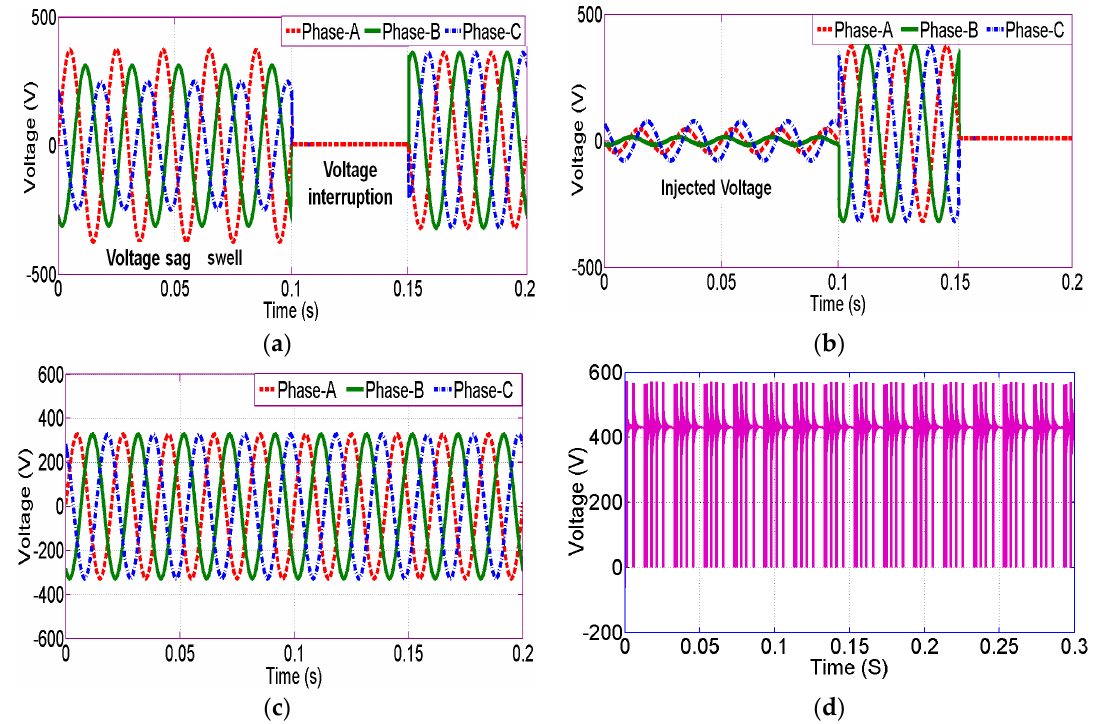
Figure 24. Simulation results of (a) source voltage; (b) compensation voltage; (c) after compensation load voltage; and (d) DC-link voltage.